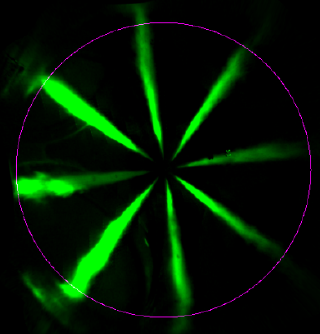
Figure A4. Stop position of the circular mask for sampling intensity.